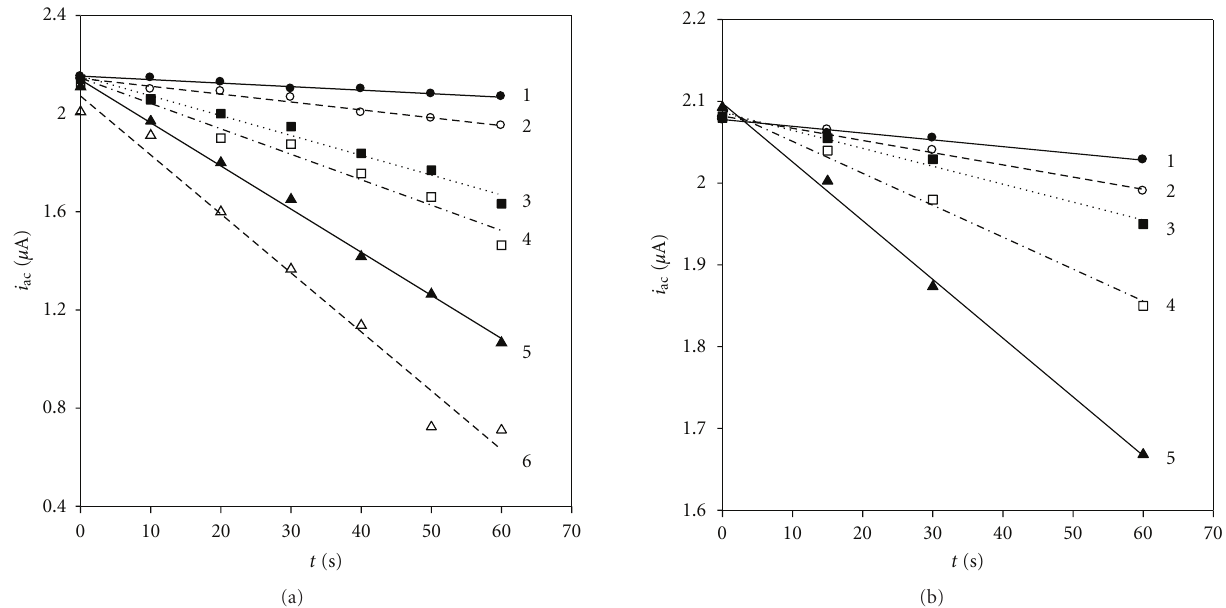
Figure 2: i ac - t curves for di ff erent concentrations of (a) T-X-100: (1) 0mgL − 1 , (2) 0.0237 mgL − 1 , (3) 0.0594 mgL − 1 , (4) 0.0951 mgL − 1 , (5) 0.143 mgL − 1 , and (6) 0.190 mgL − 1 and (b) humic acid: (1) 1.65 mgL − 1 , (2) 4.4mgL − 1 , (3) 6.6mgL − 1 , (4) 10.45 mgL − 1 , and (5) 16.5 mgL − 1 . Supporting electrolyte: 0.55M NaCl. Peak-to-peak amplitude 10mV, frequency 75Hz. Each point represents a freshly formed Hg drop.